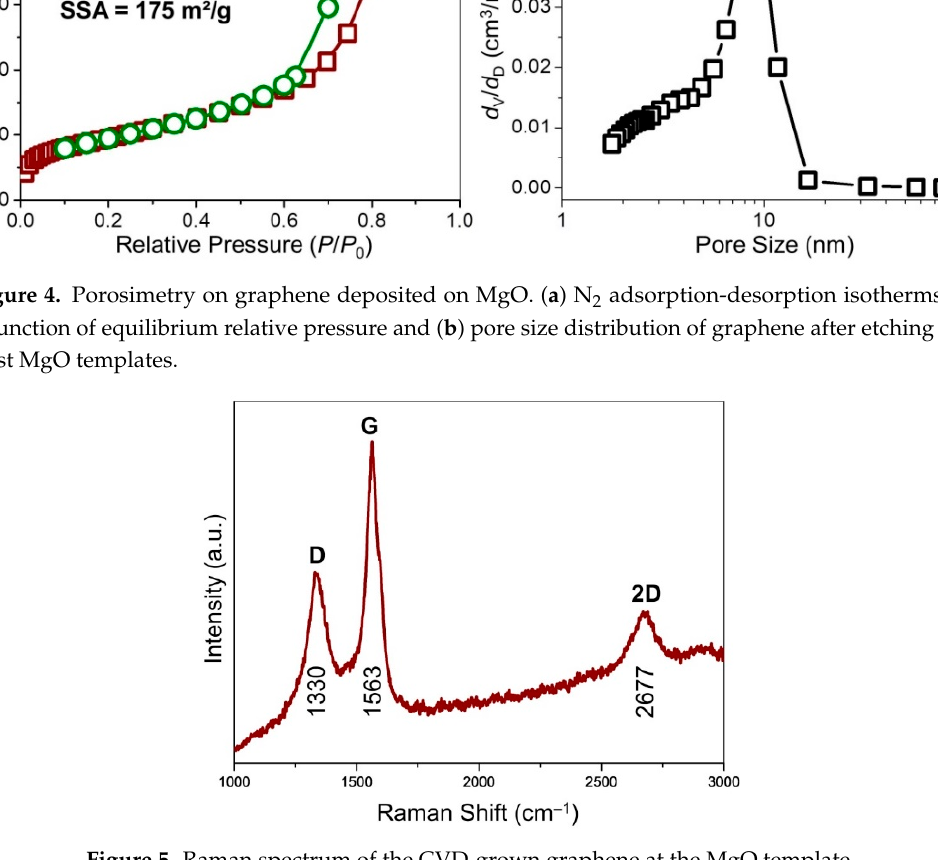
Figure 5. Raman spectrum of the CVD-grown graphene at the MgO template.